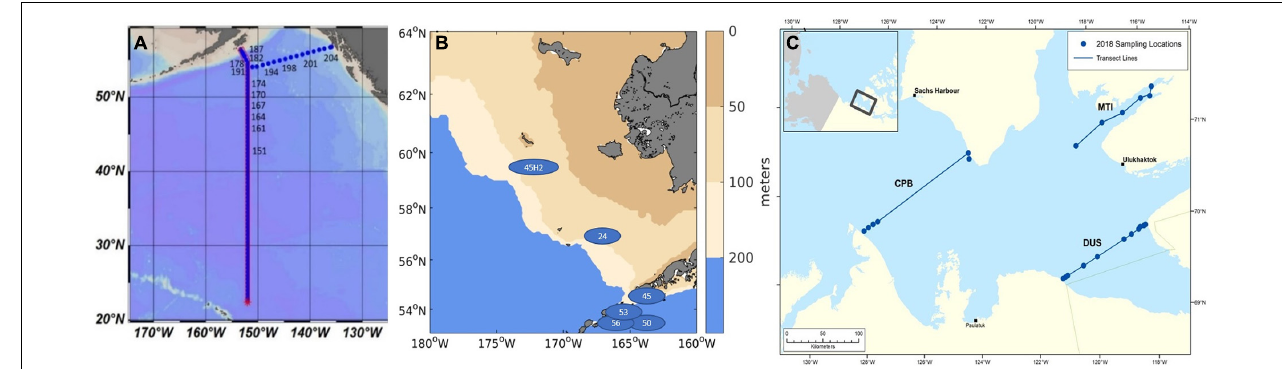
FIGURE 1 | Biological samples taken in the Eastern pacific subpolar gyre and the GoA ( A ; samples analyzed from stations 164 to 204), and the Bering Sea ( B ; blue ellipses) and Amundsen Gulf (C) with three indicated transects related to the pteropod origin (Cape Bathurst (CPB), Dolphin and Union Strait (DUS), and Minto Inlet (MTI; see Niemi et al.,